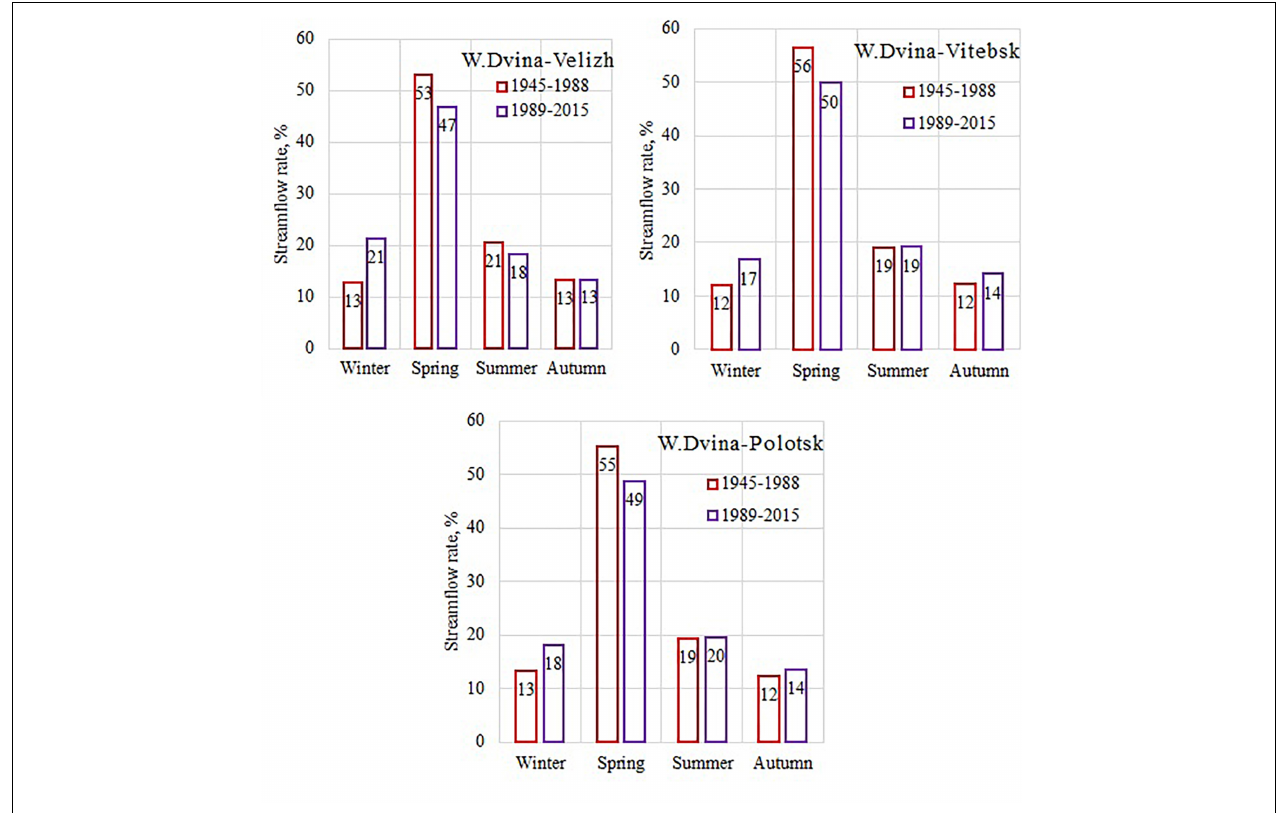
FIGURE 8 | The intra-annual streamflow distribution (percentage) on the Western Dvina River at the Velizh, Vitebsk, and Polotsk gauging